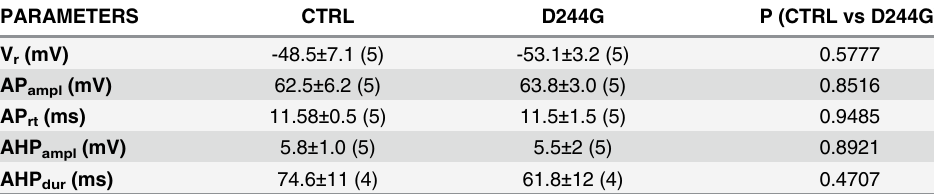
Table 1. Action potential parameters assessed from control and D244G